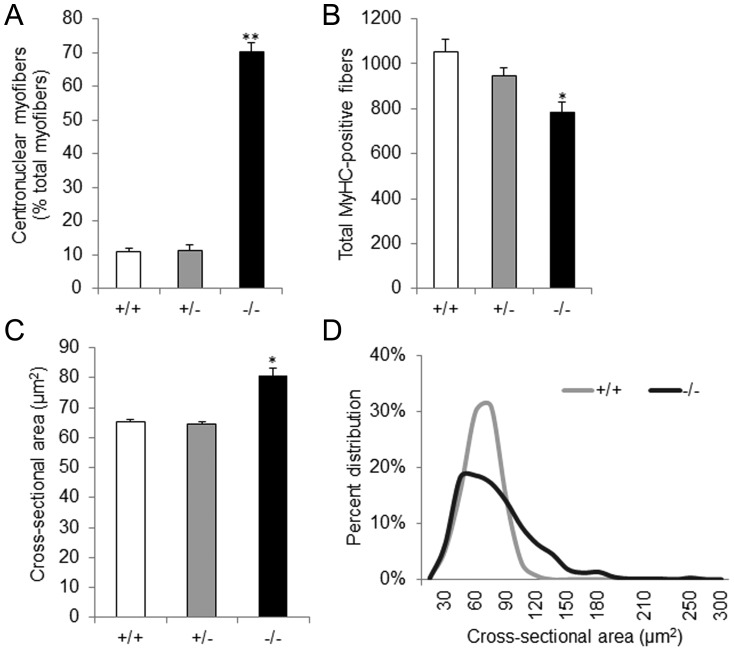
Quantitative analyses of extensor digitorum longus (EDL) muscle in newborn Stac3
−/− mice and wild-type and heterozygous littermates.
A, Percentage of myofibers that had centrally located nuclei. B, Total number of myosin heavy chain (MyHC)-positive myofibers at the widest girth of EDL muscle. C, Average cross-sectional area of myofibers in EDL muscle. D, Frequency distribution of cross-sectional areas (CSA) of myofibers in EDL muscle. Data are expressed as mean ± SEM (n = 3 to 7). * P<0.05 and ** P<0.01 vs. wild-type or heterozygous mice.